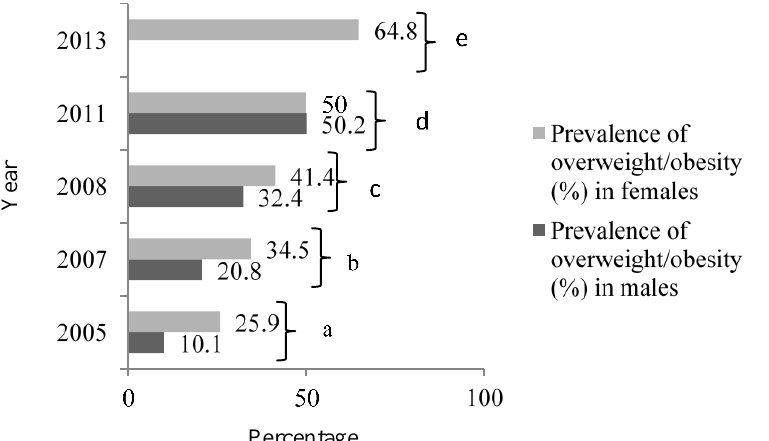
Figure 1. Prevalence of overweight/obesity in India,